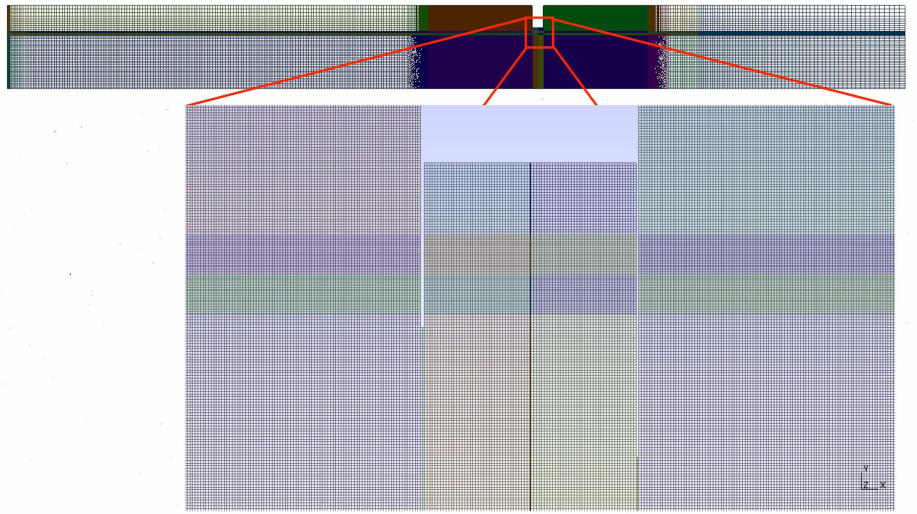
Figure 8. Discretization of the computational domain employed in the methodology